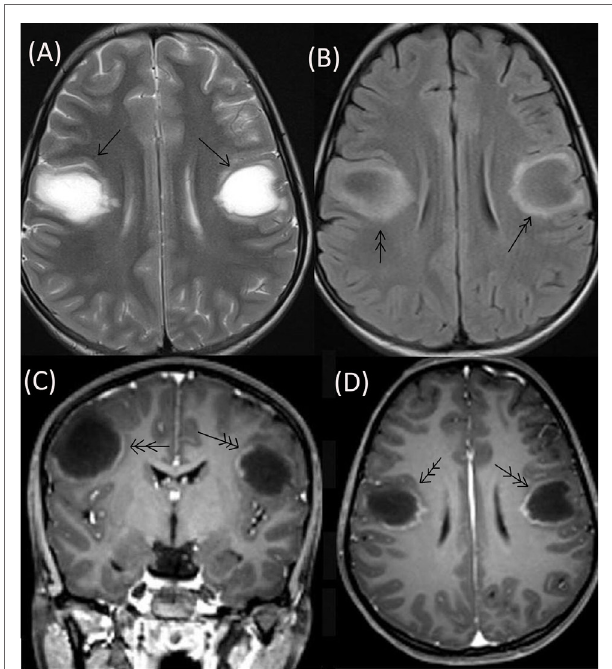
FIGURe 3 | Repeat MRI brain showing bilateral frontal–parietal hyperintensities on t2 sequence (single arrow) with central